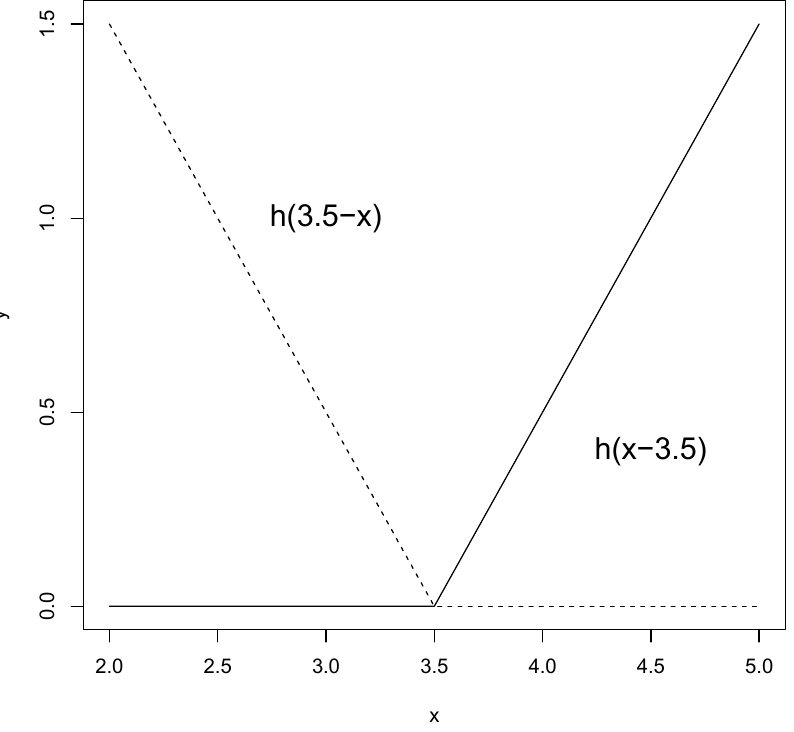
Figure 4. A graphical representation of a spline basis function. The left spline ( tx  ,   tx  ) is shown as a dashed line and the right spline ( tx  ,   tx  ) as a solid